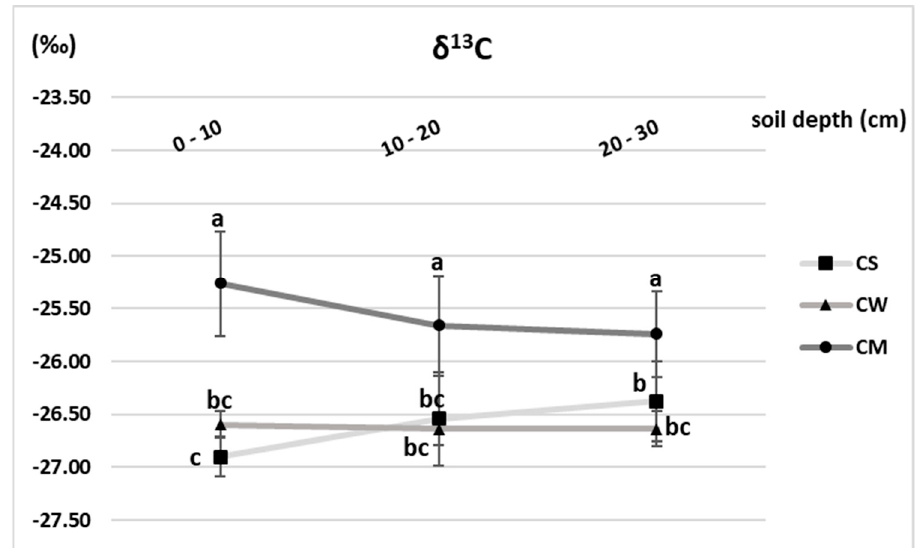
Figure 6. δ 13 C values (‰) of unplanted soil (CS), soil cultivated by wheat (CW) and soil cultivated by miscanthus (CM) at depths (0–10, 10–20 and 20–30 cm). Values are presented as means ± SD. Different letters refer to significant differences in soils (Fisher LSD test, n = 4, p ≤ 0.05).